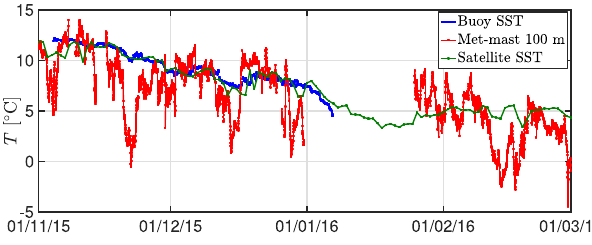
Figure 5. Time series of temperatures measured by the satellites, mast and buoy.